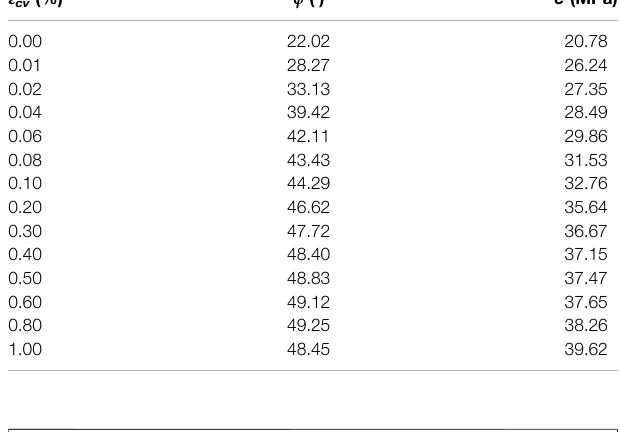
FIGURE 6 | Relationship between deviator stress and ε D cv .